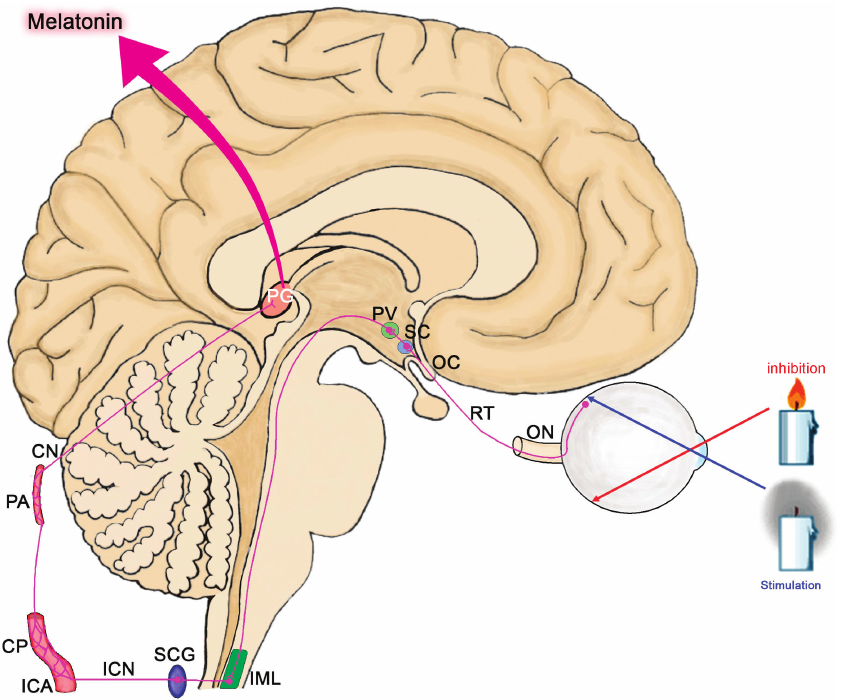
Fig. 1 Anatomy of pathway of stimulation of the pineal gland. CN, conarii or pineal nerve; ICA, internal carotid artery; ICN, internal carotid nerve; ICP, internal carotid plexus; IML, intermediolateral column; OC, optic chiasm; ON, optic nerve; PA, pineal artery; PG, pineal gland; PV, paraventricular nucleus; RT, retinohypothalamic tract; SC, suprachiasmatic nucleus; SCG, superior cervical ganglion.